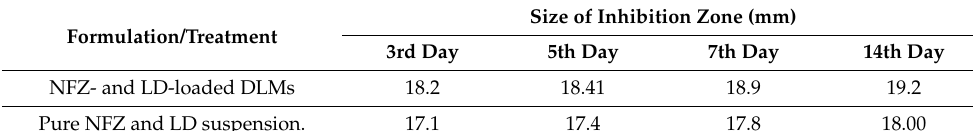
Table 3. A comparison of in vitro antibacterial analysis of DLMs and pure drugs. Formulation/Treatment